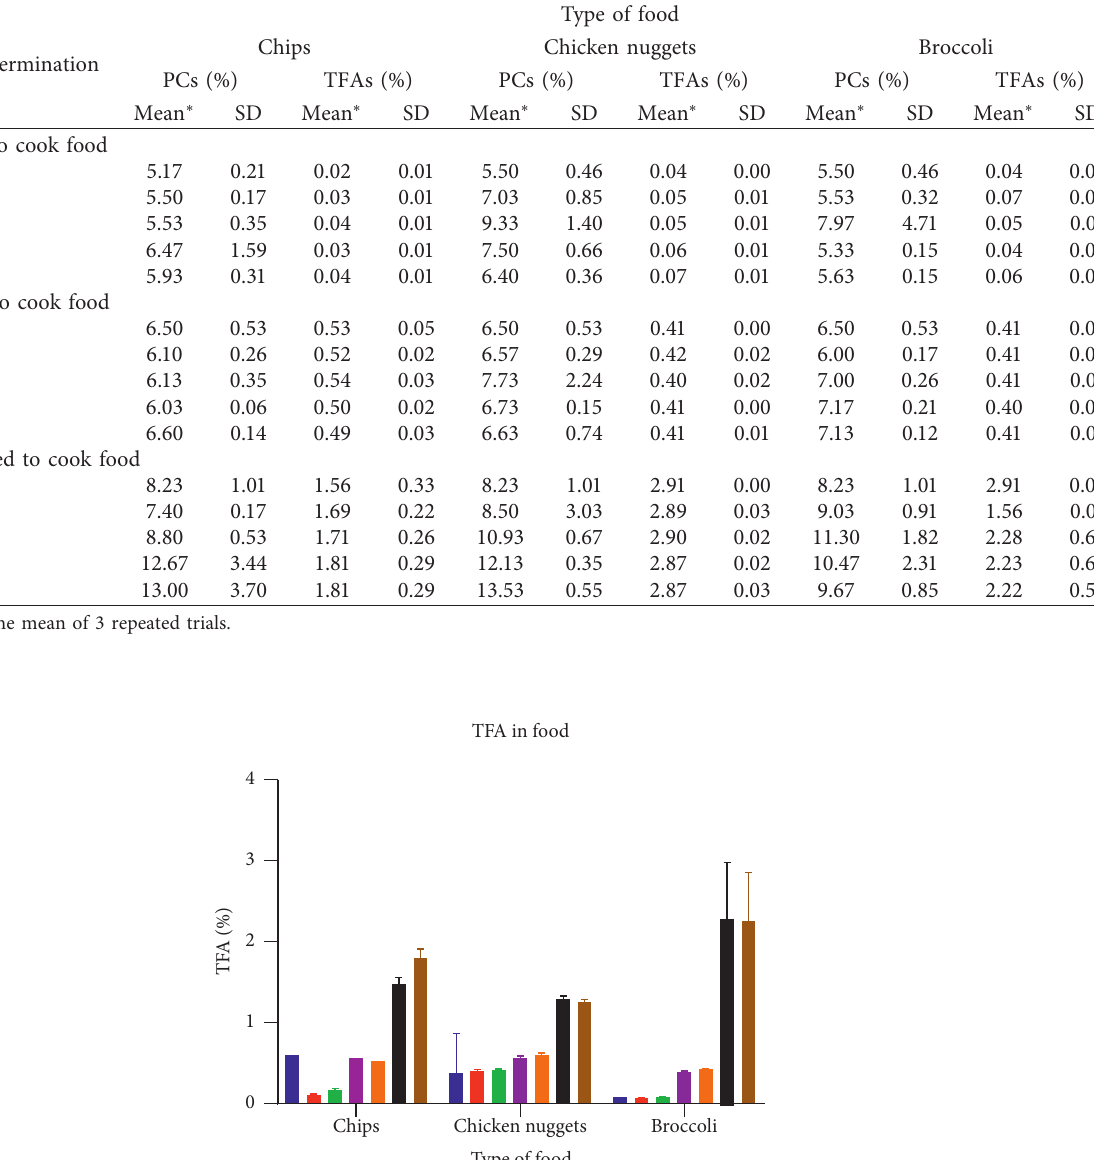
Table 5: PCs and TFAs in the oils used for deep-frying.